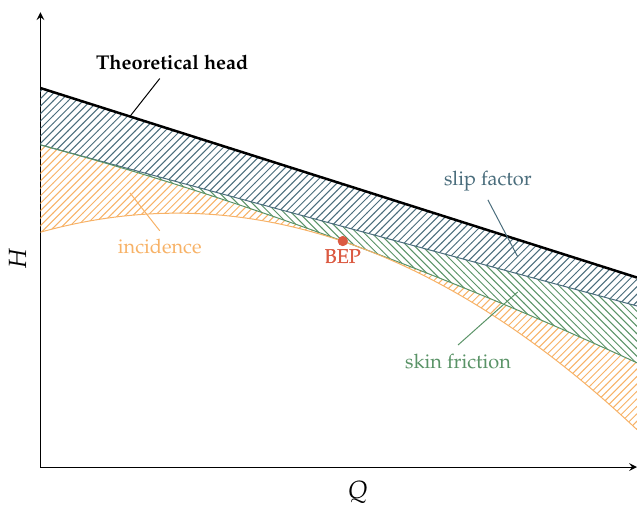
Figure 9. Qualitative H-Q curve of a pump stage, with theoretical head, slip losses, friction losses and shock (incidence) losses.